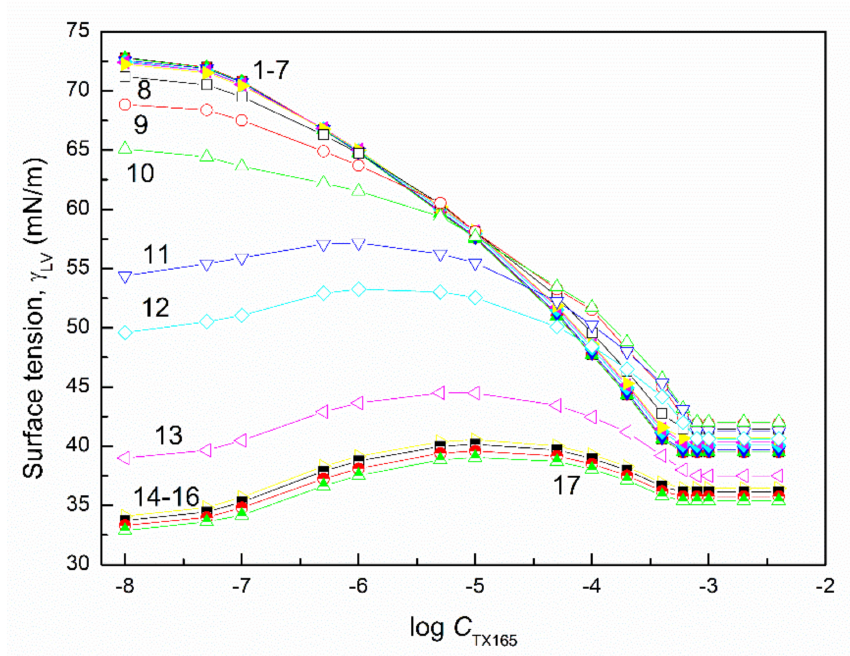
Figure 4. A plot of the surface tension ( γ LV ) of the aqueous solution of the SF and TX165 mixture vs. the logarithm of the TX165 concentration ( C TX165 ). Curves 1 − 16 correspond to the constant SF concentration equal to 0.0002, 0.0005, 0.00125, 0.003, 0.00625, 0.01, 0.02, 0.05, 0.1, 0.5, 1, 5, 10, 20, 30, and 40 mg/dm 3 , respectively.